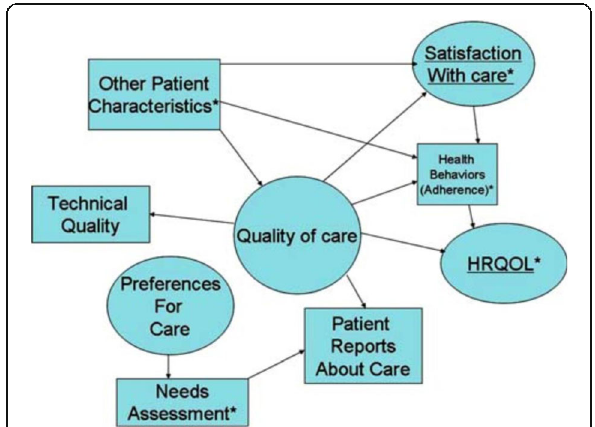
Fig. 1 Fung and Hays Conceptual Model for Patient Reported